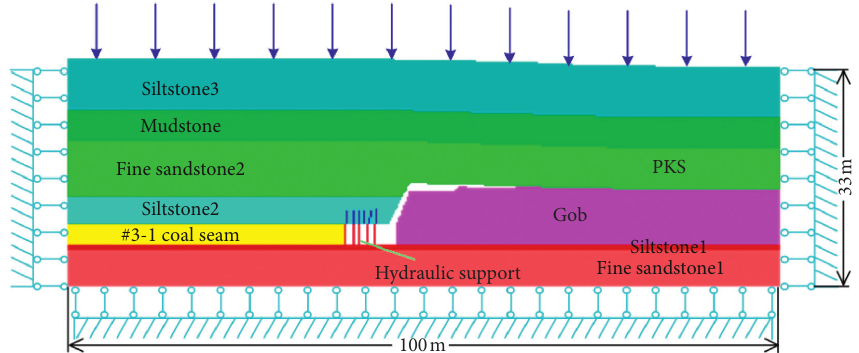
Figure 12: Numerical model of the recovery roadway in the Liangshuijing coal